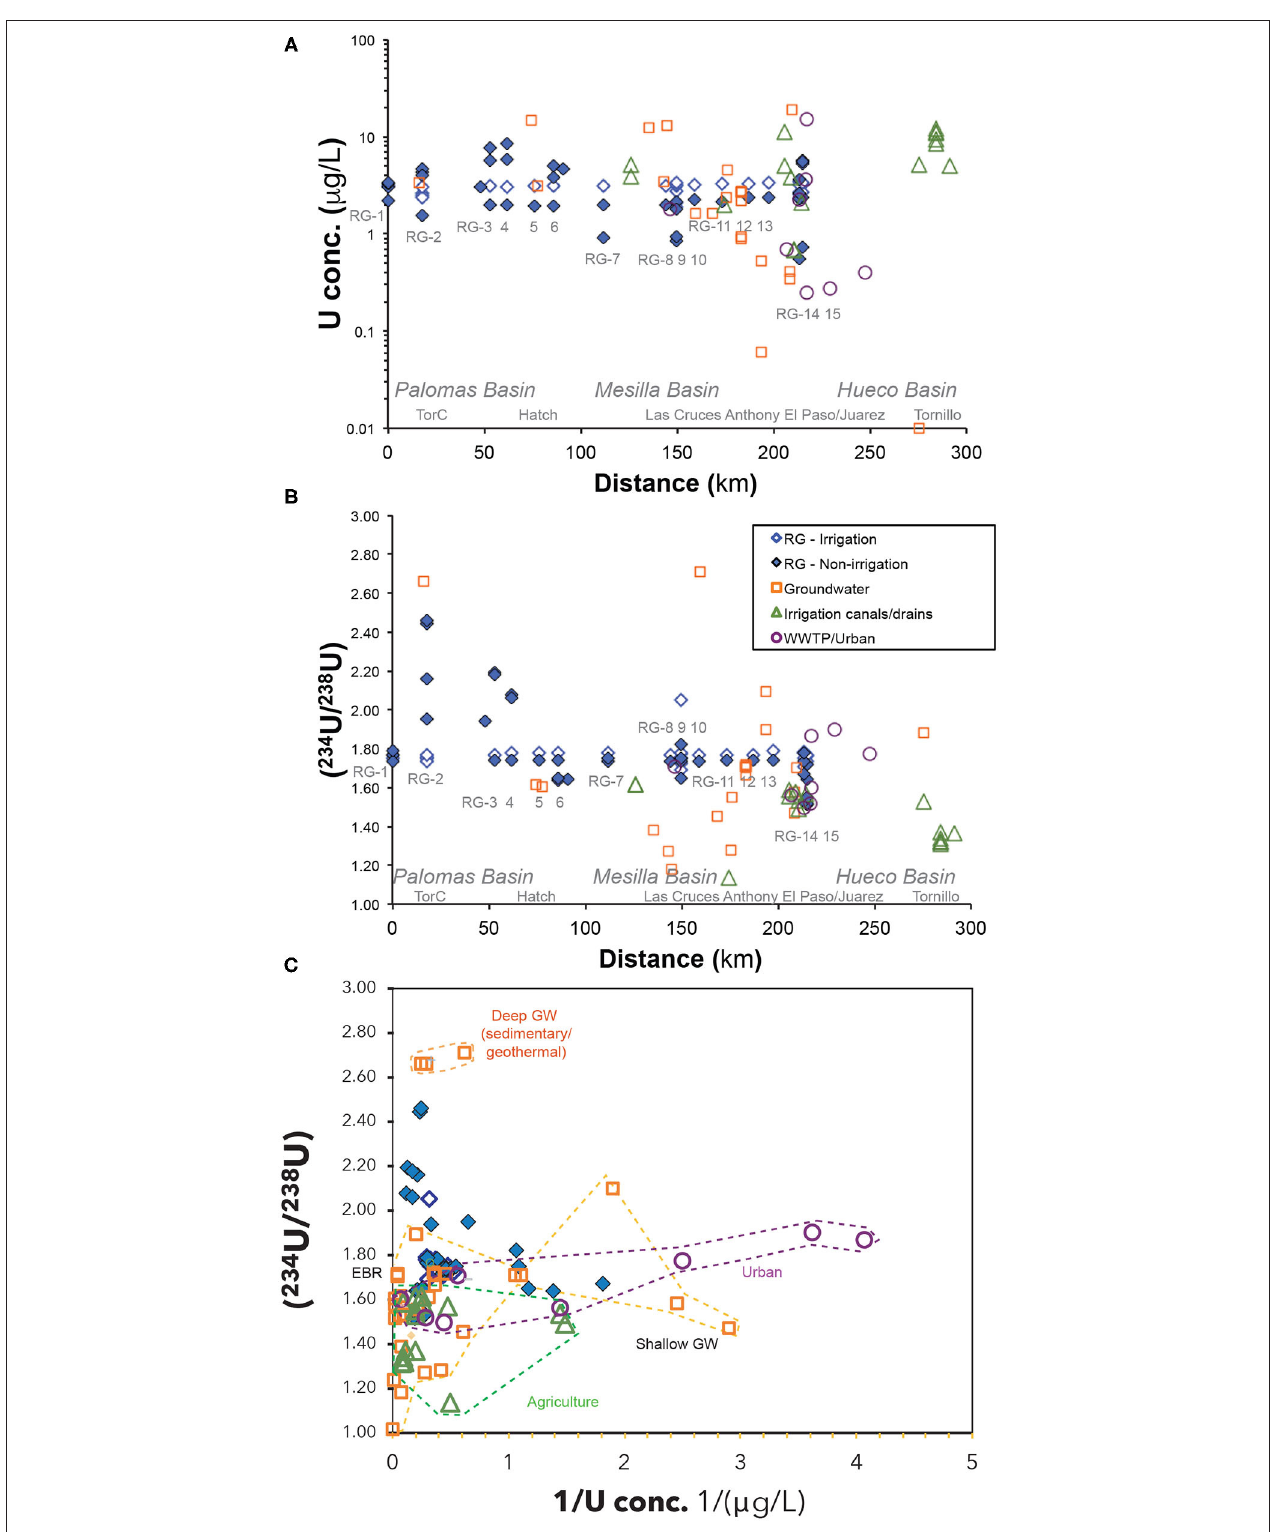
FIGURE 5 | (A) U concentrations and (B) activity ratios in the Rio Grande river water, groundwater, agricultural canals and drains, and urban water (waste water treatment plants). The Rio Grande water is classified into non-irrigation and irrigation seasons. The sample locations are placed with distance (km) from Elephant Butte Reservoir along the Rio Grande. (C) U activity ratios vs. 1/U concentrations. End members for Elephant Butte Reservoir, shallow groundwater, deep groundwater, agricultural water, and urban water are indicated and outlined.